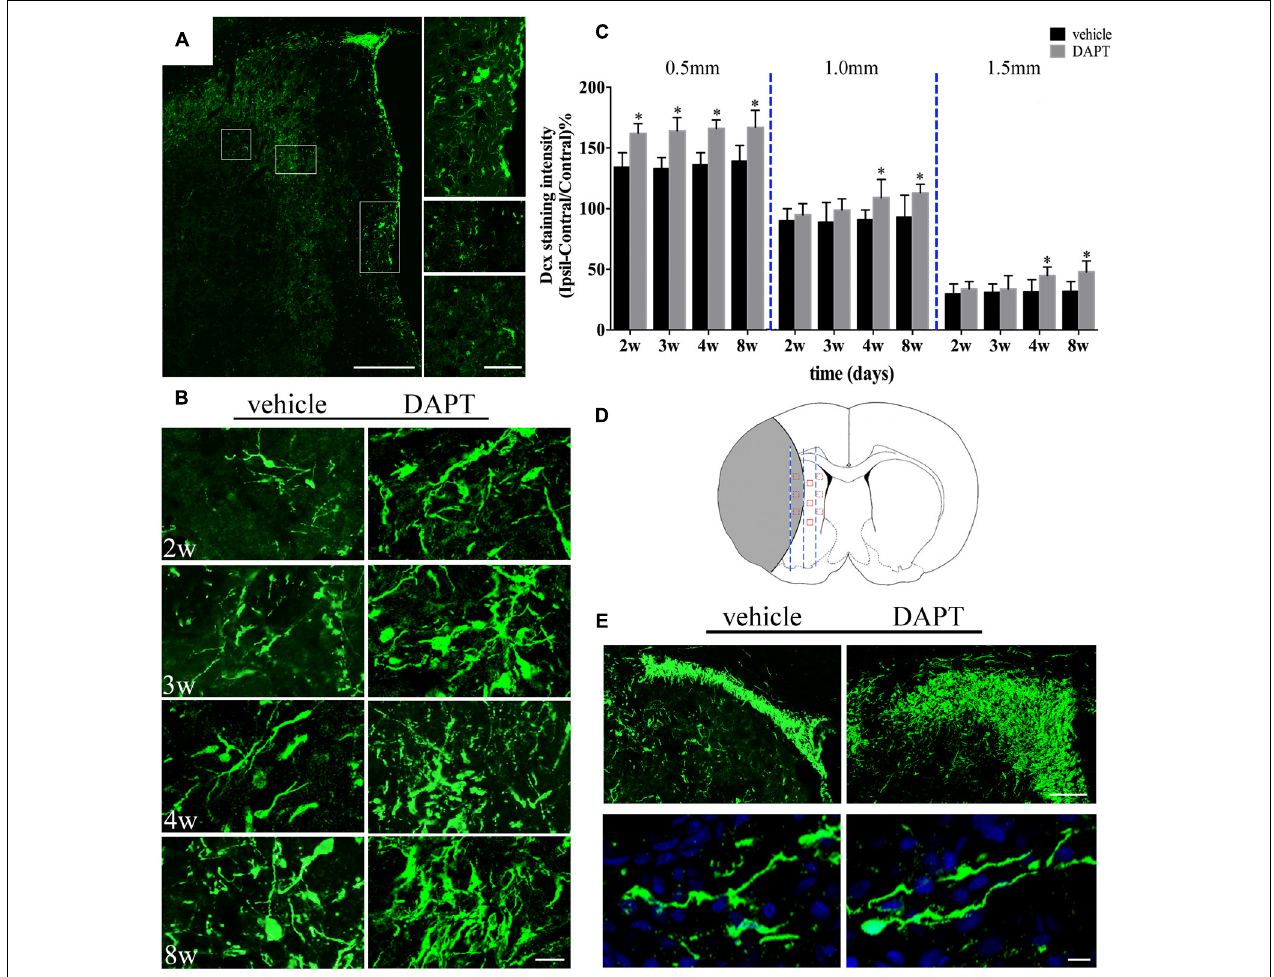
FIGURE 7 | Effects of DAPT on neuroblasts activity after MCAO. (A) Boxes in the “photomerged” image shows the distribution of Dcx (+) cells across the ischemic boundary to the lesion. Scale bar = 100 and 50 µ m. (B) Immunostaining of Dcx inside 0.5mm distances from the SVZ in two group rats from 2 to 8w. Scale bar = 20 µ m. (C) Comparisons of Dcx fluorescence intensity in two group rats at different distances from the SVZ 2, 3, 4, and 8 weeks after MCAO. 0.5 mm: ∗ P < 0.05, 2, 3, 4, 8w versus DAPT and vehicle. 1.0 mm, 1.5mm: ∗ P < 0.05, 4w, 8w versus DAPT and vehicle. (D) Anatomical references showing the ROIs. (E) Representative images of the location of Dcx (+) cells in the anterior SVZ and shape of Dcx (+) cells in the ischemic boundary of two group rats 8 weeks after MCAO. Scale bar = 50 and 10 µ